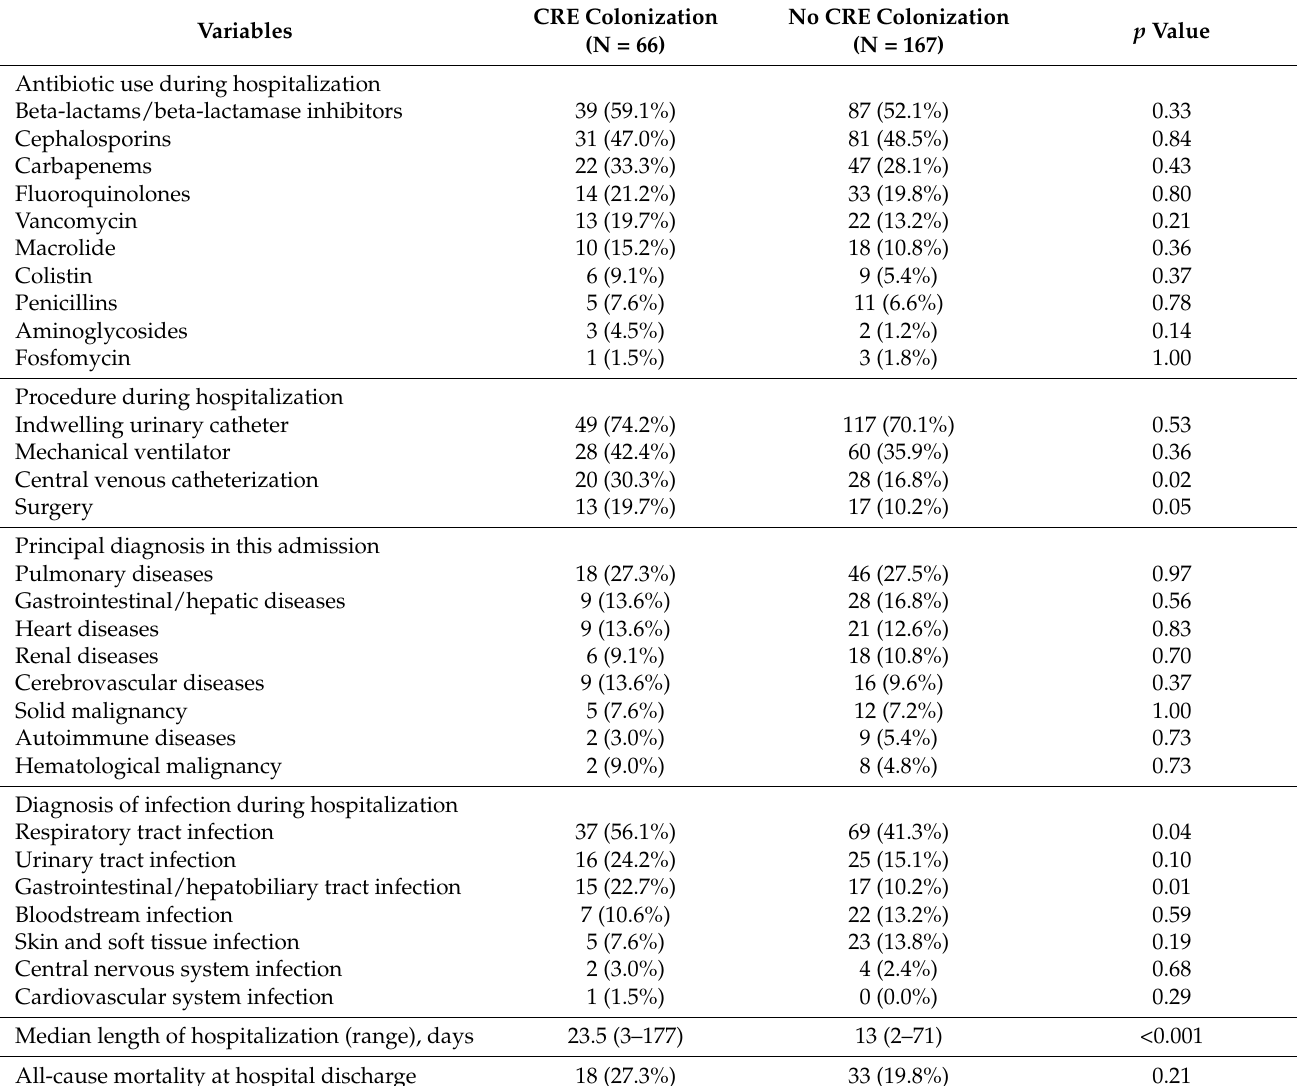
Table 3. Comparison of 233 patients with and without CRE acquisition during